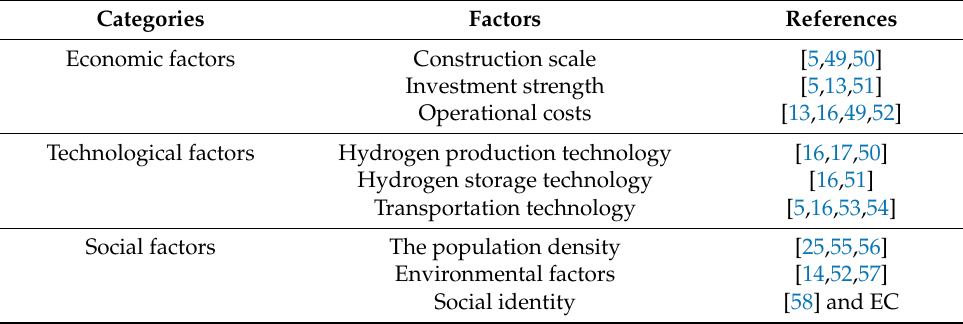
Table 1. Factors affecting HRSs planning in